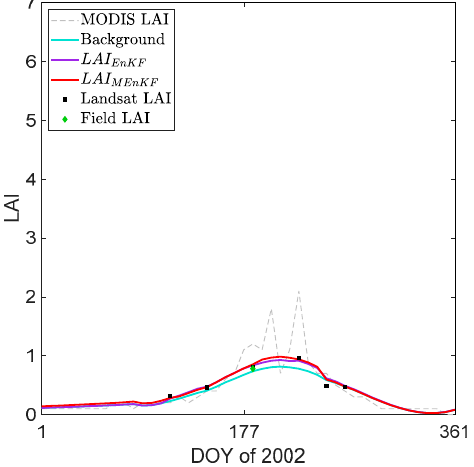
Figure 5. LAI time series generated by MEnKF for grassland.